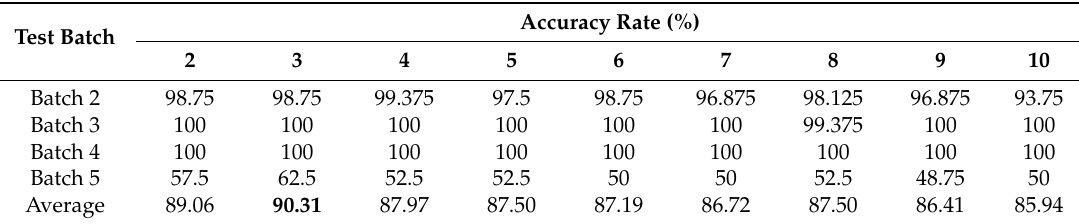
Table 3. The performance of QWKFDA using polynomial kernel with the number of base kernels from 2 to 10.